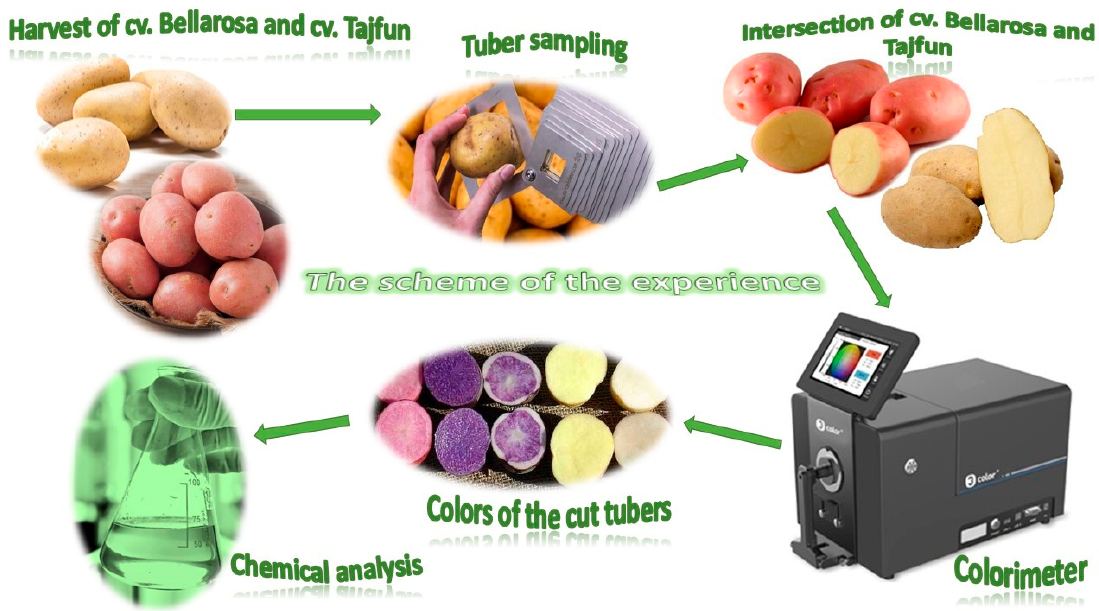
Figure 2. Abstract graphic of the experiment.